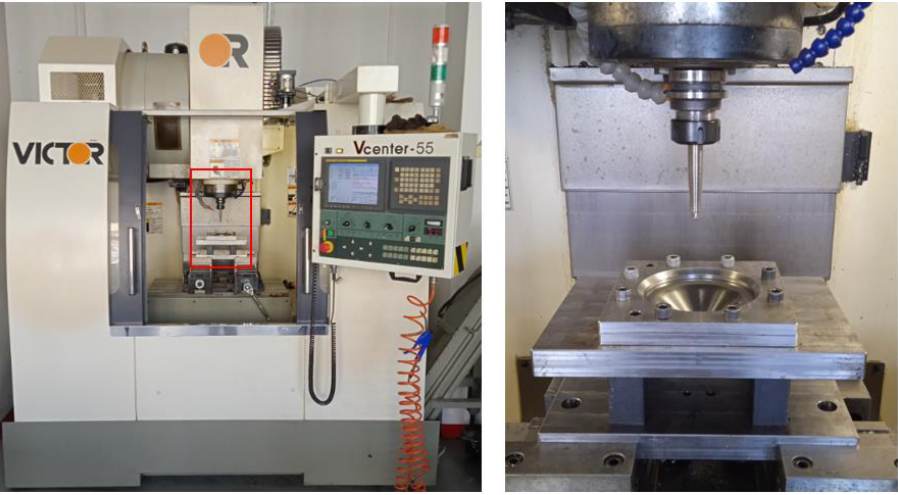
Figure 9. Technological setup used for the implementation of the SPIF process, adapted with permission from ref. [5].